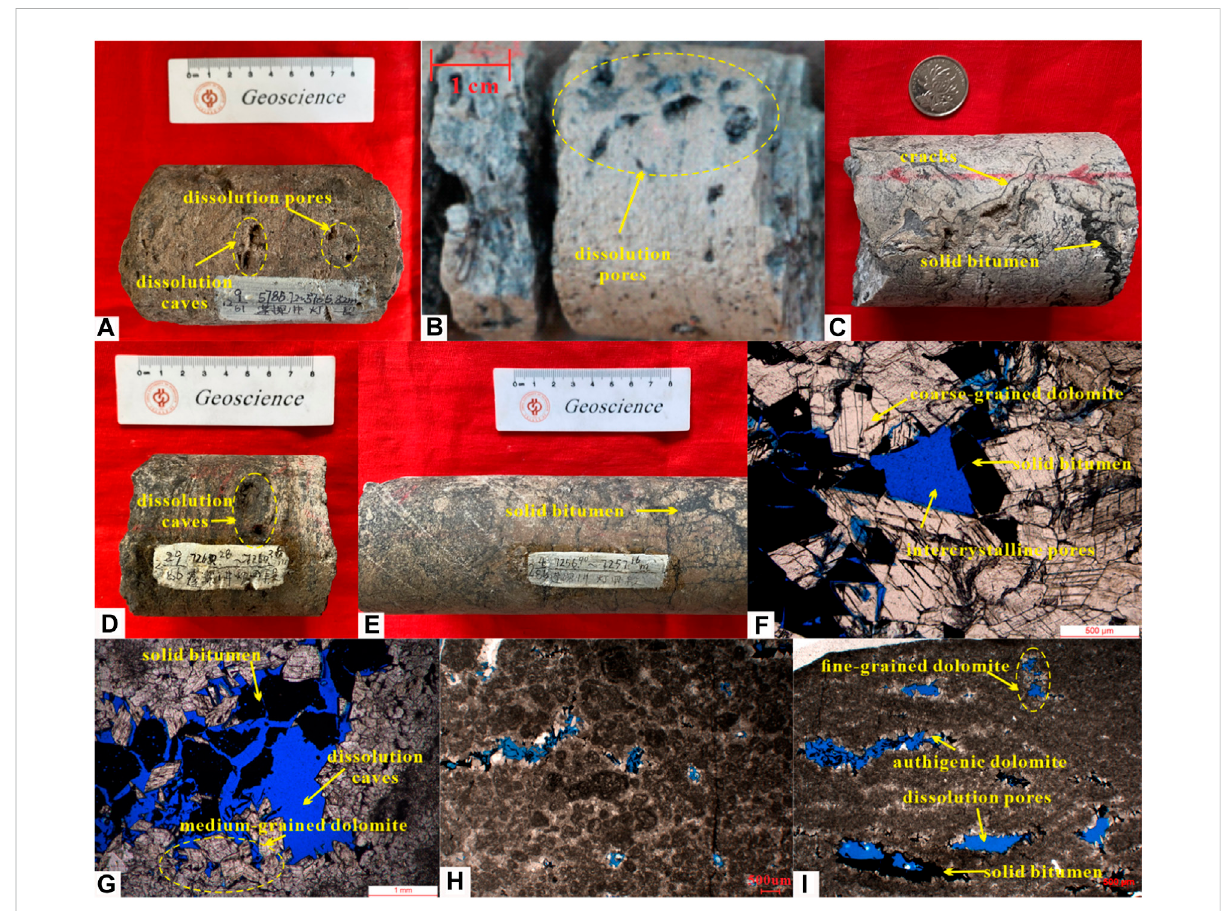
the occurrence of solid bitumen in cores and pore space. (A) PT1, 5785.72-5785.82 m, D-2, algal sandy dolomite, with solid bitumen fi lling in the dissolution pores and caves; (B) PT1, 5729 m, D-2, algal sandy dolomite, with developed cracksa and dissolution pores fi lled with solid bitumen; (C) ZJ2, 6546.27 m, D-2, algal dolomite, with solid bitumen fi lling in the dissolved pores and cracks; (D) PS1, 7260.28-7260.36 m, D-4, algal stromatolitic dolomite; (E) PS1, 7256.90-7257.16 m, D-4, microcrystalline dolomite, with solid bitumen fi lling in the dissolved cracks; (F) PT1, 5729.44 m, D-2, algal sandy dolomite, coarse-grained dolomite, bitumen partialy fi lling inthe inter-crystalline pores of coarse-crystalline-dolomite; (G) ZJ2, 6553.56 m, D-2, algal dolomite, medium-grained dolomite, bitumen partialy fi lling in the inter-crystalline dissolved caves; (H) PS1, 7260.28 m, D-4, algal stromatolitic dolomite, inter-crystalline and intragranular pores partially fi lled by the solid bitumen after fi ne-grained authigenic dolomite formed; (I) PS1, 7262.41-7262.54 m, D-4, microcrystalline dolomite, bitumen fi lling in the intragranular pores after fi ne-grained authigenic dolomite